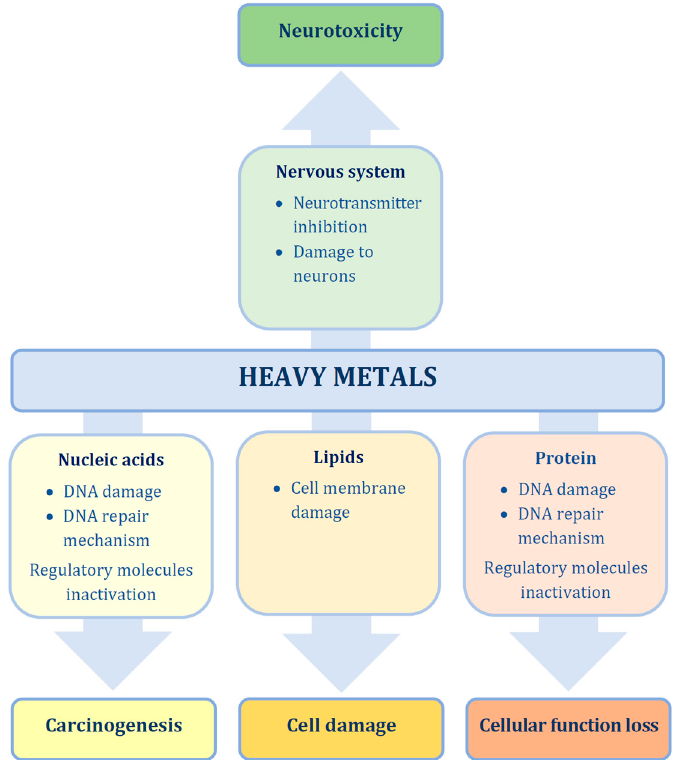
Figure 9. The pathways of heavy metal ions in the human body and their effects. Adapted with permission from Briffa, J. D et al., Heliyon ; Elsevier Ltd. CC BY-NC-ND license (http://creativecommons.org/licenses/by-nc-nd/4.0/, 18 November 2022), 2020 [114].